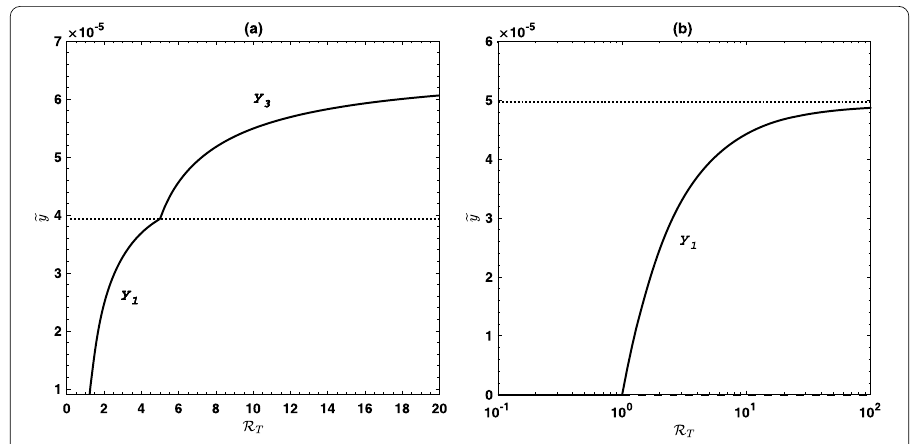
Figure 5 Bifurcation diagram showing the endemic prevalence of infection as a function of the effective reproduction number with treatment R T for values of Y ≥ Y 2 . Part ( a ) shows the case where Y 2 < Y < Y 1 ( Y = 0.8 Y 1 ), while part ( b ) shows the case Y > Y 1 ( Y = 1.01 Y 1 ). The horizontal dotted straight line correspond to (cid:14) y = Y . Simulations have been done with the parameter values shown in Table 1.